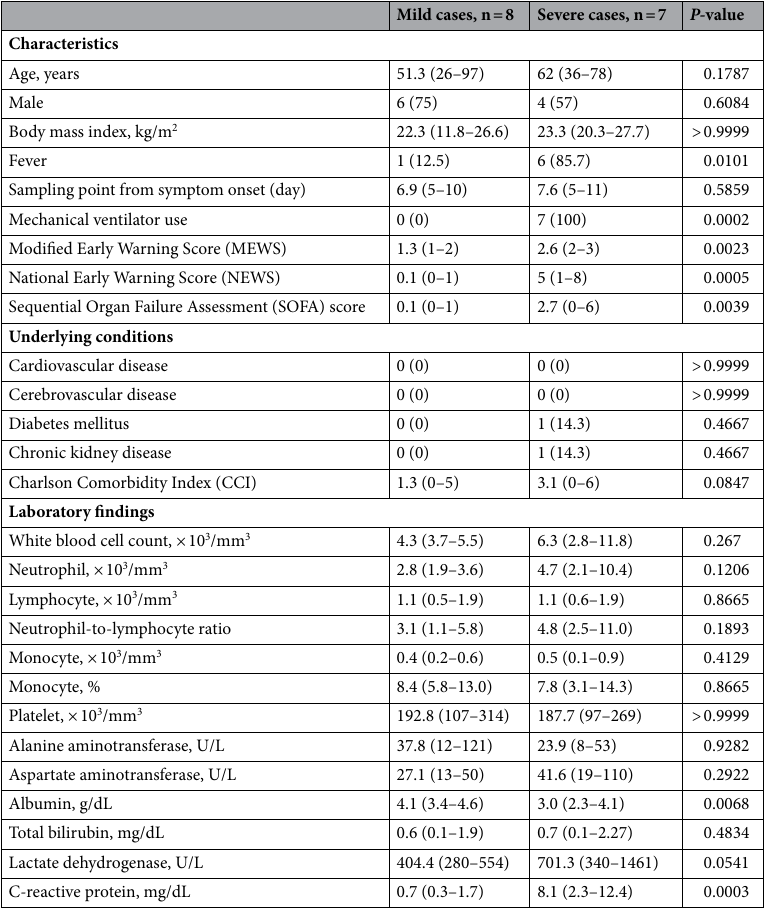
Table 1. Characteristics and laboratory findings of patients with COVID-19. Data were presented as mean (ranges) or numbers (%). P-values were calculated by Mann–Whitney